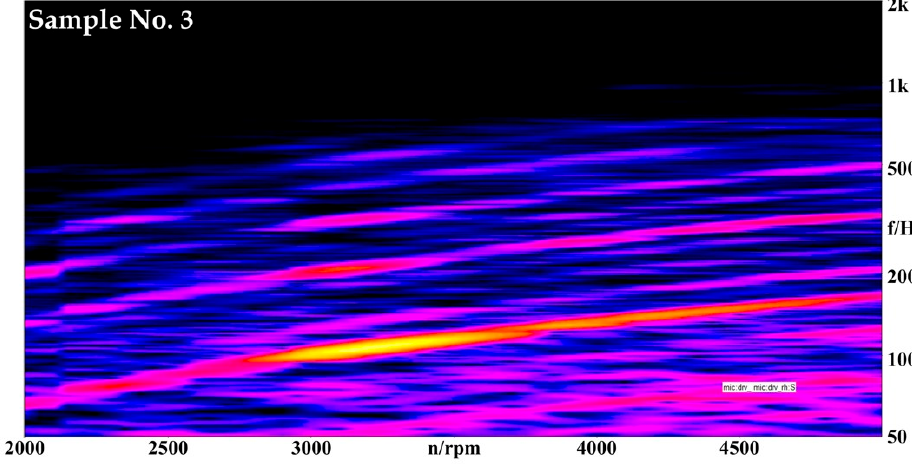
Figure 5. Results of spectrum analysis for samples with the highest (upper side) and lowest (lower side) 320 score of perceived refined. 321